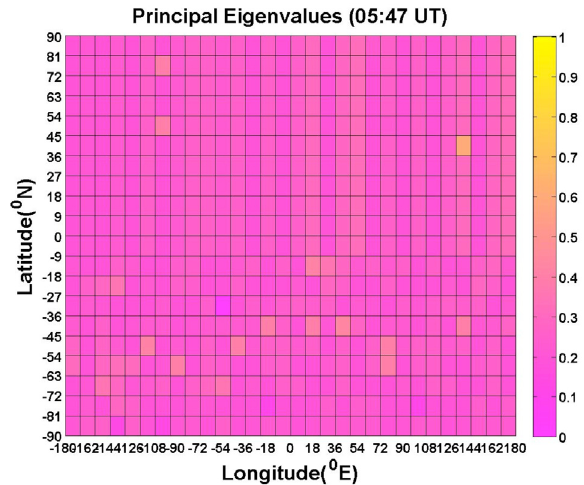
Figure 5. The figure gives a color-coded scale of the magnitudes of principal eigenvalues corresponding to Figure 2. The color within a grid denotes the magnitude of assigned principal eigenvalues, respec- tively. Note it resulted in an eigenvalue in any place of each grid. How- ever, for convenience to show, each grid was filled with a uniform color. This study has shown large eigenvalue near the